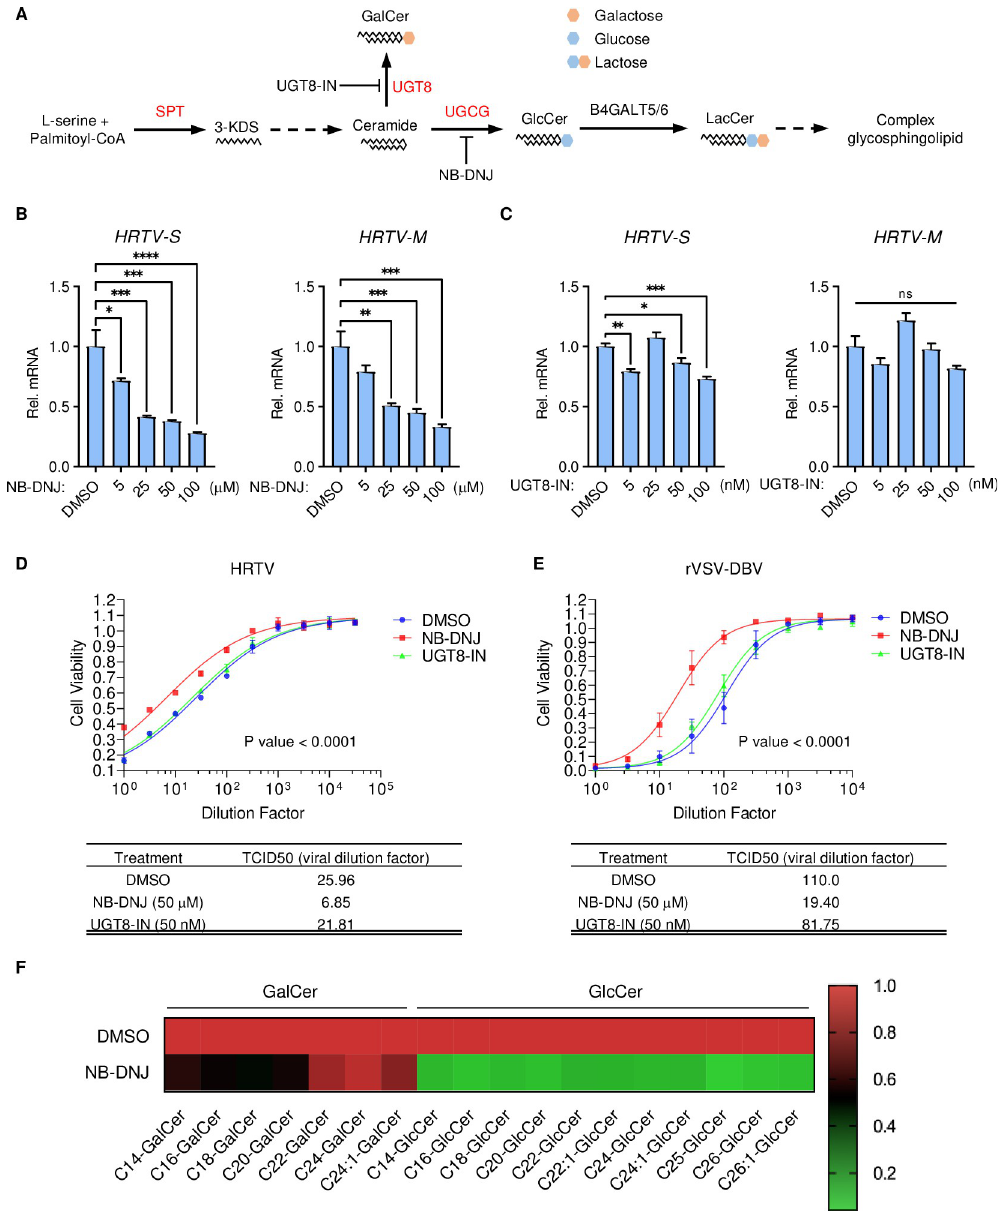
Fig 2. Glucosylceramide biosynthesis pathway is essential for HRTV infection. A. Diagram of glycosphingolipid biosynthesis pathway. Genes highlighted in red were identified from CRISPR/Cas9 screen. B-C. Effect of NB-DNJ or UGT8-IN on HRTV replication. 293T cells were pre-treated with NB-DNJ or UGT8-IN for 24 hours before infection with HRTV (MOI = 1). Viral RNAs of the S-segment and M-segment were measured by qPCR and normalized to GAPDH mRNA. Data shown are means ± SEM from representative experiments (n = 3 technical replicates). P values were determined by ordinary one-way ANOVA with Dunnett’s multiple comparison tests. ���� , P < 0.0001; ��� , P < 0.001; �� , P < 0.01; � , P < 0.05. D-E. Effect of NB-DNJ and UGT8-IN on HRTV or rVSV-DBV infection. To generate a replication- competent rVSV-DBV, the VSV glycoprotein in its genome was replaced with DBV Gn/Gc. After incubation with indicated drugs for 24 hours, half-log serially diluted HRTV or rVSV-DBV was added to 4 replicate wells of a 96-well plate containing 293T cells for 72 hours. TCID 50 was calculated by plotting cell viability versus dilution factor using GraphPad Prism and fitted by a dose-response (variable slope) algorithm. F. Heat map of the levels of intracellular GalCer and GlcCer in 293T cells with or without NB-DNJ treatment.